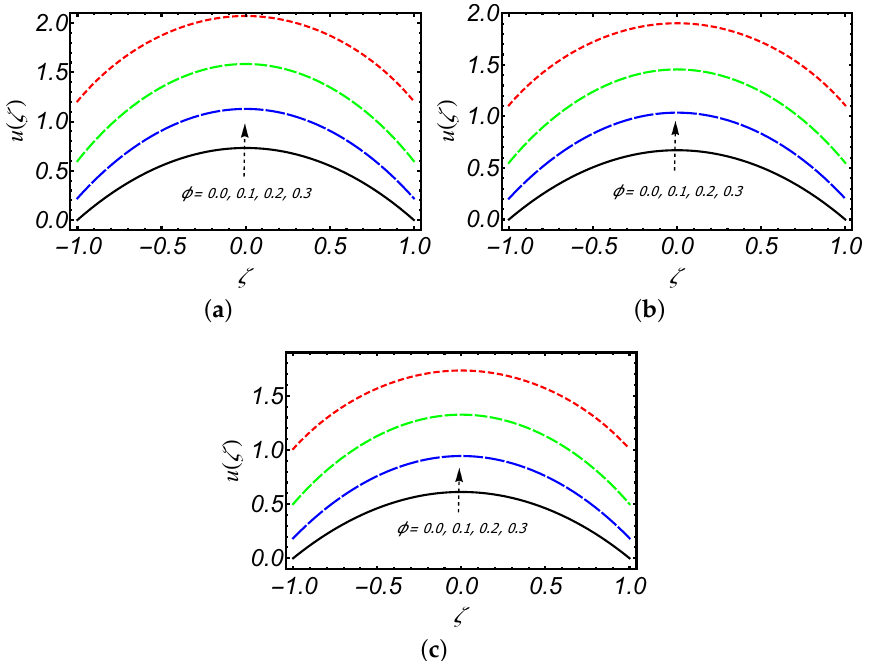
Figure 8. Behavior of u ( ζ ) with φ at ( a ) x = 0.1, ( b ) x = 0.5, ( c ) x = 0.9, when K = 0.2, δ = 0.2.